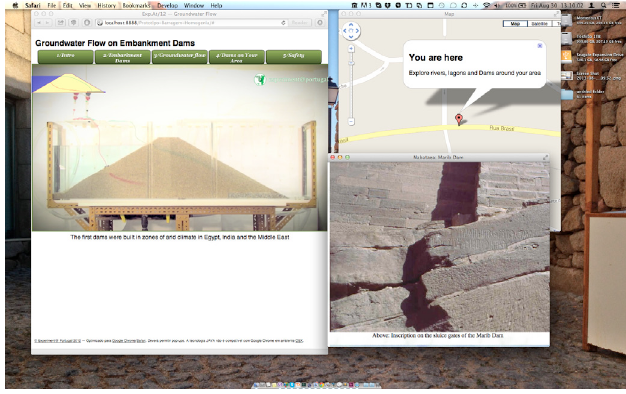
Figure 6. Screen shot of the interactive video on groundwater flow in embankment